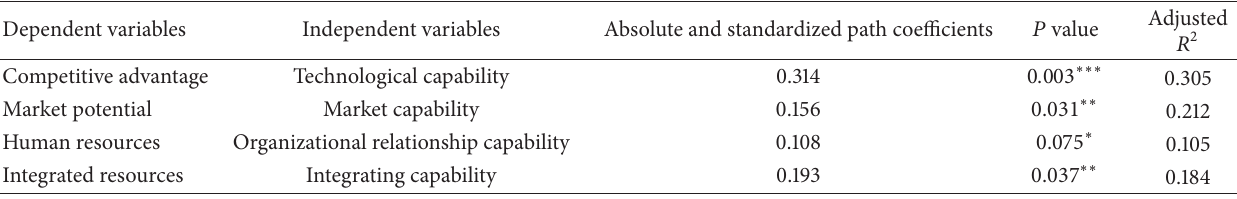
Table 4: Path analysis between 4 strategic objectives and 13 extracted CSFs. (Small technology-based firms expended by differentiated products.)